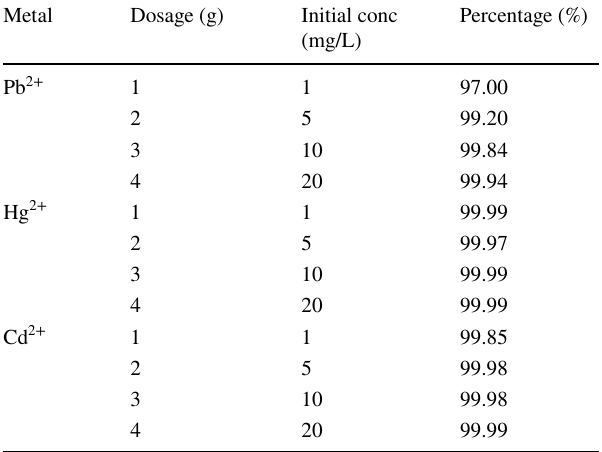
Table 1 Adsorption efficiency of the toxic metals by cacao pod husk